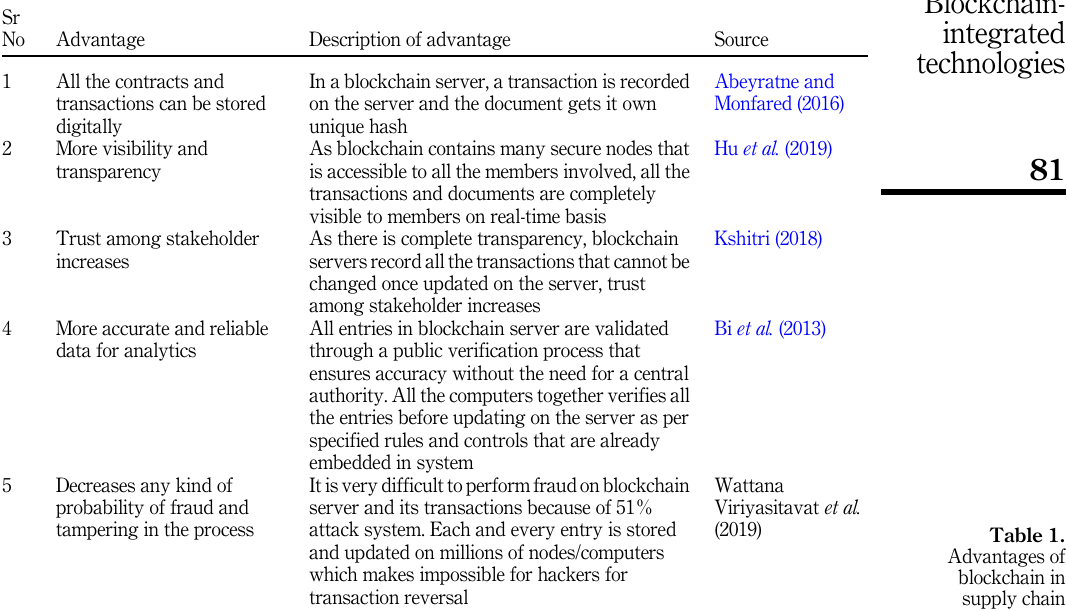
Table 1. Advantages